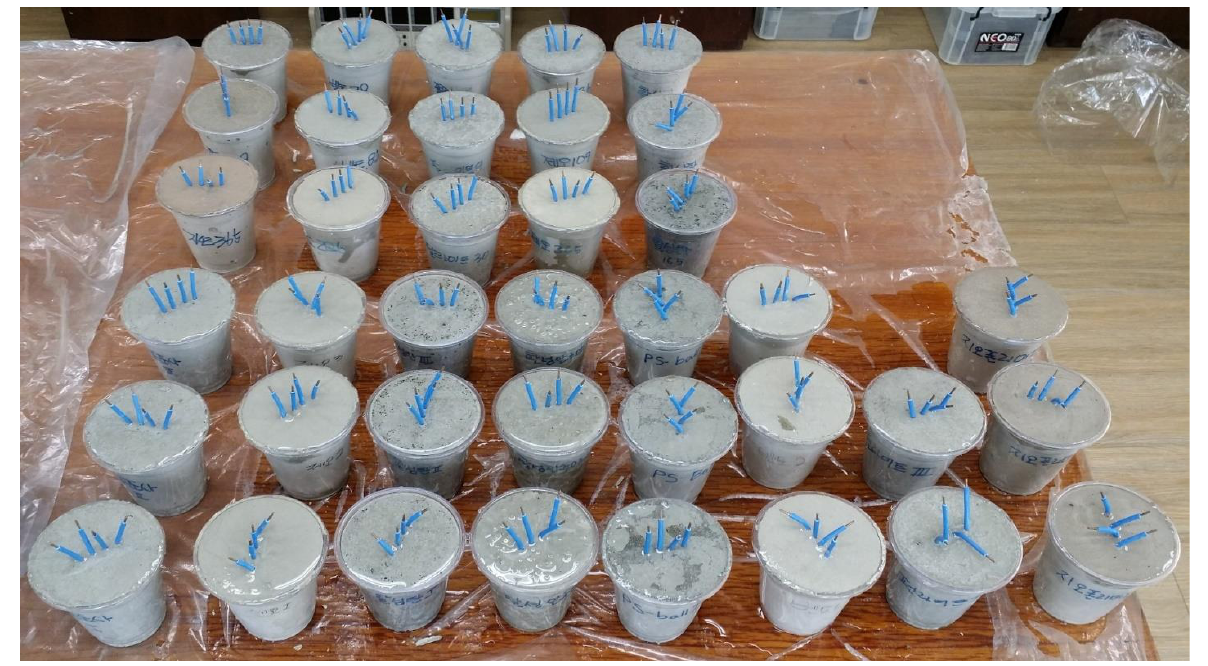
Figure 1. Prepared cup-shaped mortar specimens for resistivity measurement. Table 1. Mix design.